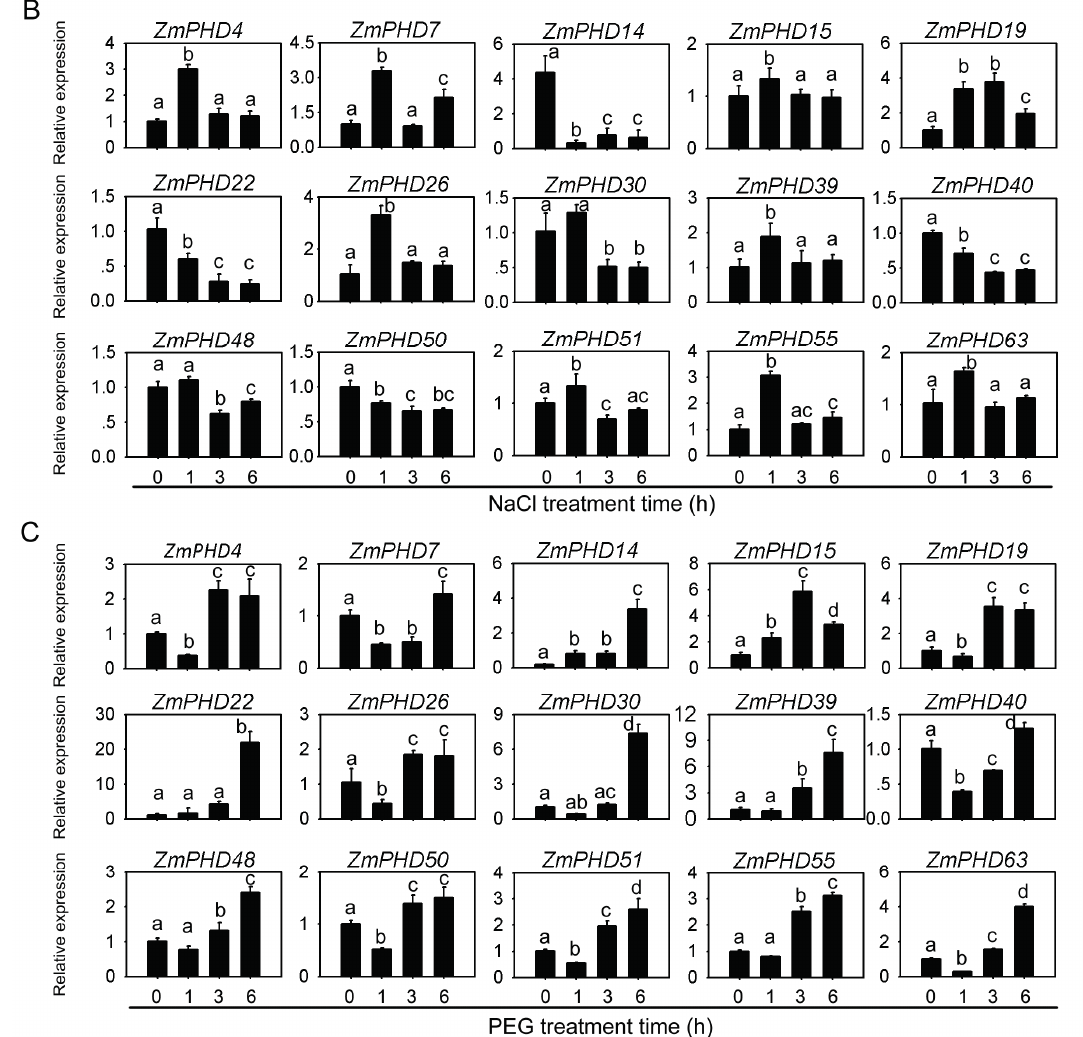
Figure 8. Expression patterns of PHD group IX genes in response to drought, NaCl and ABA treatments. The relative expression level of 15 PHD group IX genes was examined by the qRT-PCR and normalized with the reference gene ZmGAPDH . ( A ) Relative expression of 15 PHD genes under ABA treatment at 0, 1, 3, 6 h; ( B ) Relative expression of 15 PHD genes under NaCl treatment at 0, 1, 3, 6 h; and ( C ) Relative expression of 15 PHD genes under PEG6000 treatment at 0, 1, 3, 6 h. The error bars represent standard deviations (SD), y -axes are scales of relative expression level and x -axes are the time course of treatments for each condition. Different lowercase letters indicate significant differences at p <